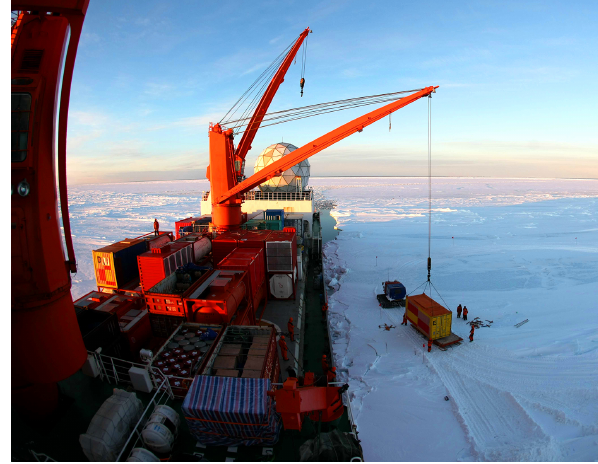
Figure 14. Scenario of unloading cargos from an icebreaker on landfast sea ice in the Prydz Bay (Photo credit: Shiping